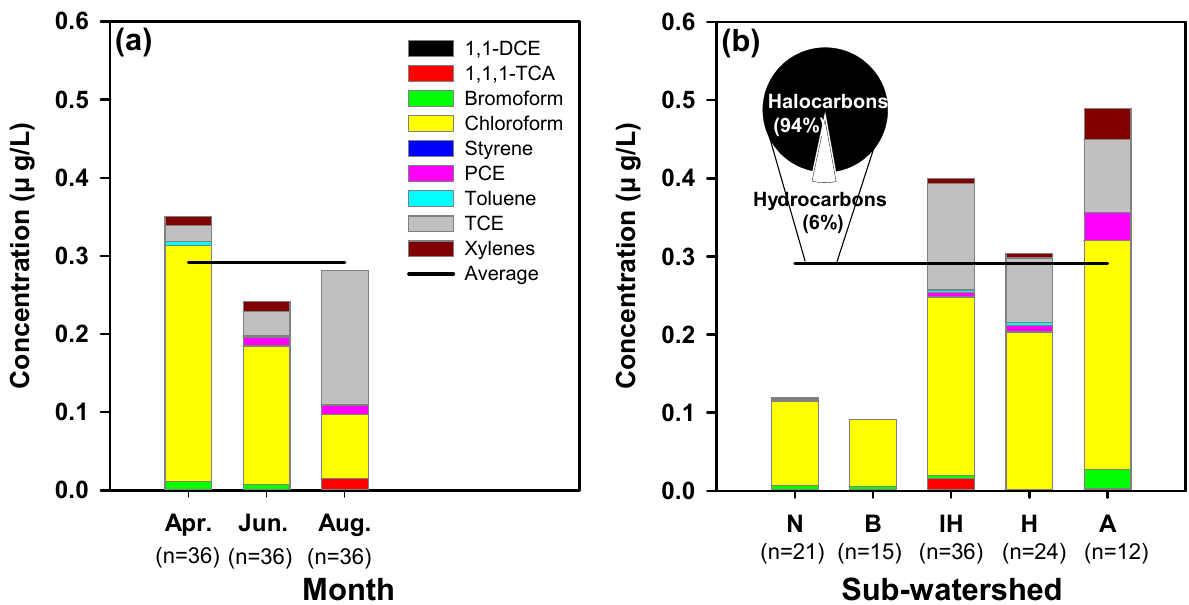
Figure 3. ( a ) Temporal and ( b ) spatial variations in VOC concentrations. Xylenes include m ‐ , o ‐ , and p ‐ isomers of xylene; undetected naphthalene and vinyl chloride were excluded. N: Namhan River; B: Bukhan River; IH: Imjin ‐ Hantan River; H: Han River mainstream; A: Anseong Stream.